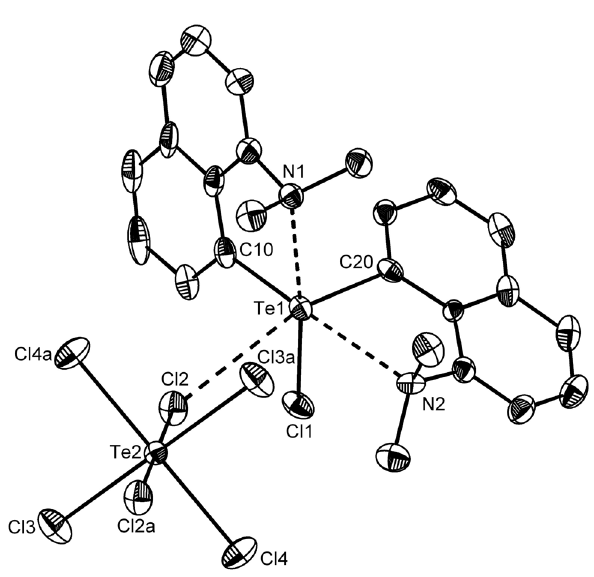
NC H ) TeCl] TeCl ( 1 ) 2 10 6 2 2 6